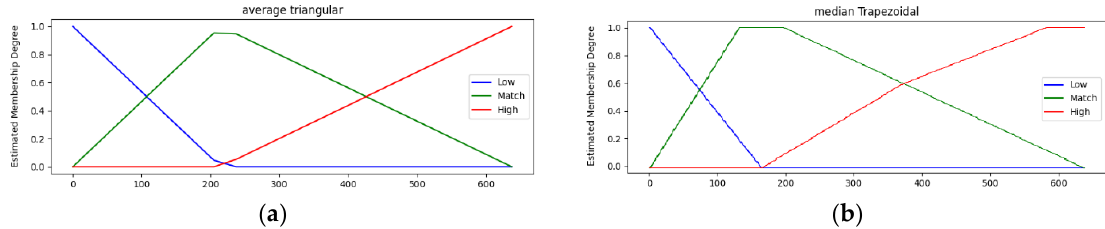
Figure 3. The figure above shows an example of a fuzzy set of a fuzzy inference system and its membership function. As can be seen in the figure, the fuzzy inference system has a method of defining all the degree values for each fuzzy set for one input and combining them to determine. ( a ) is triangular, and ( b ) is a trapezoidal model.